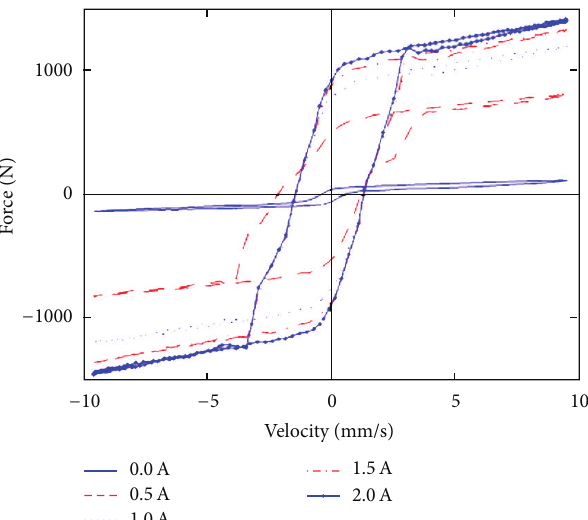
Figure 17: The damping force versus velocity